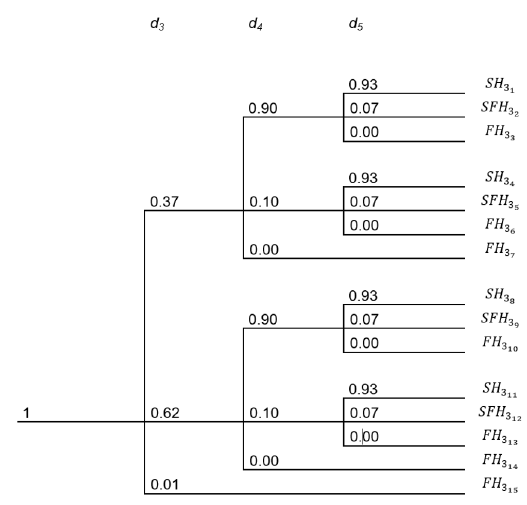
Figure 13. Event tree for activity (Sending the advice note list z 2 .).